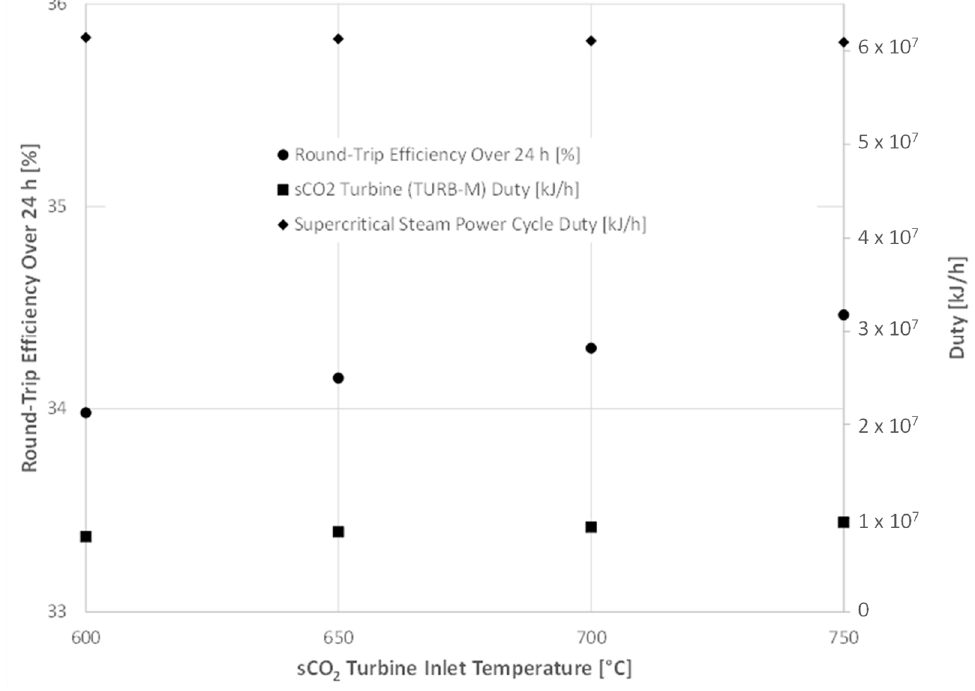
Figure 8. Round-trip efficiency and power cycle duty as a function of sCO 2 turbine inlet temperature. Increasing the inlet temperature of the sCO 2 turbine has a minimal impact on round- trip efficiency, with a temperature increase of 150 ◦ C leading to an efficiency increase of only 0.5%. This is because increasing the sCO 2 turbine inlet temperature, while increasing the power produced by the sCO 2 turbine, decreases the amount of heat available to be extracted in HX-L, thereby decreasing the power produced by the supercritical steam